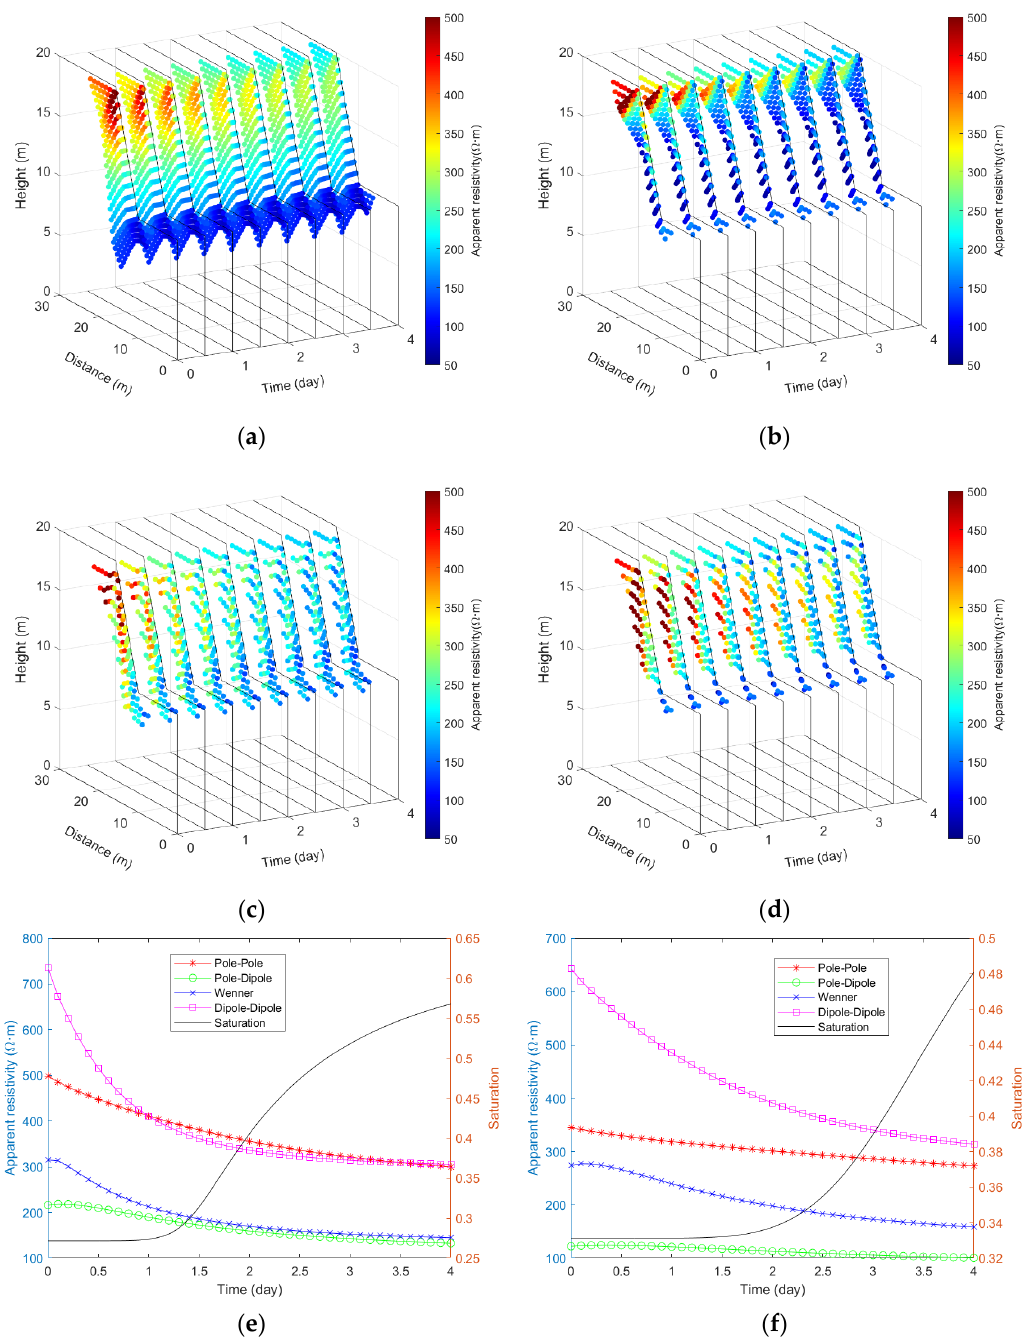
Figure 4. Apparent resistivity response of various arrays during rainfall: ( a ) Pole-Pole array; ( b ) Pole-Dipole array; ( c ) Wenner array; ( d ) Dipole-Dipole array. ( e ) The evolution of apparent resistivity and saturation at point A with time. ( f ) The evolution of apparent resistivity and saturation at point B with time.